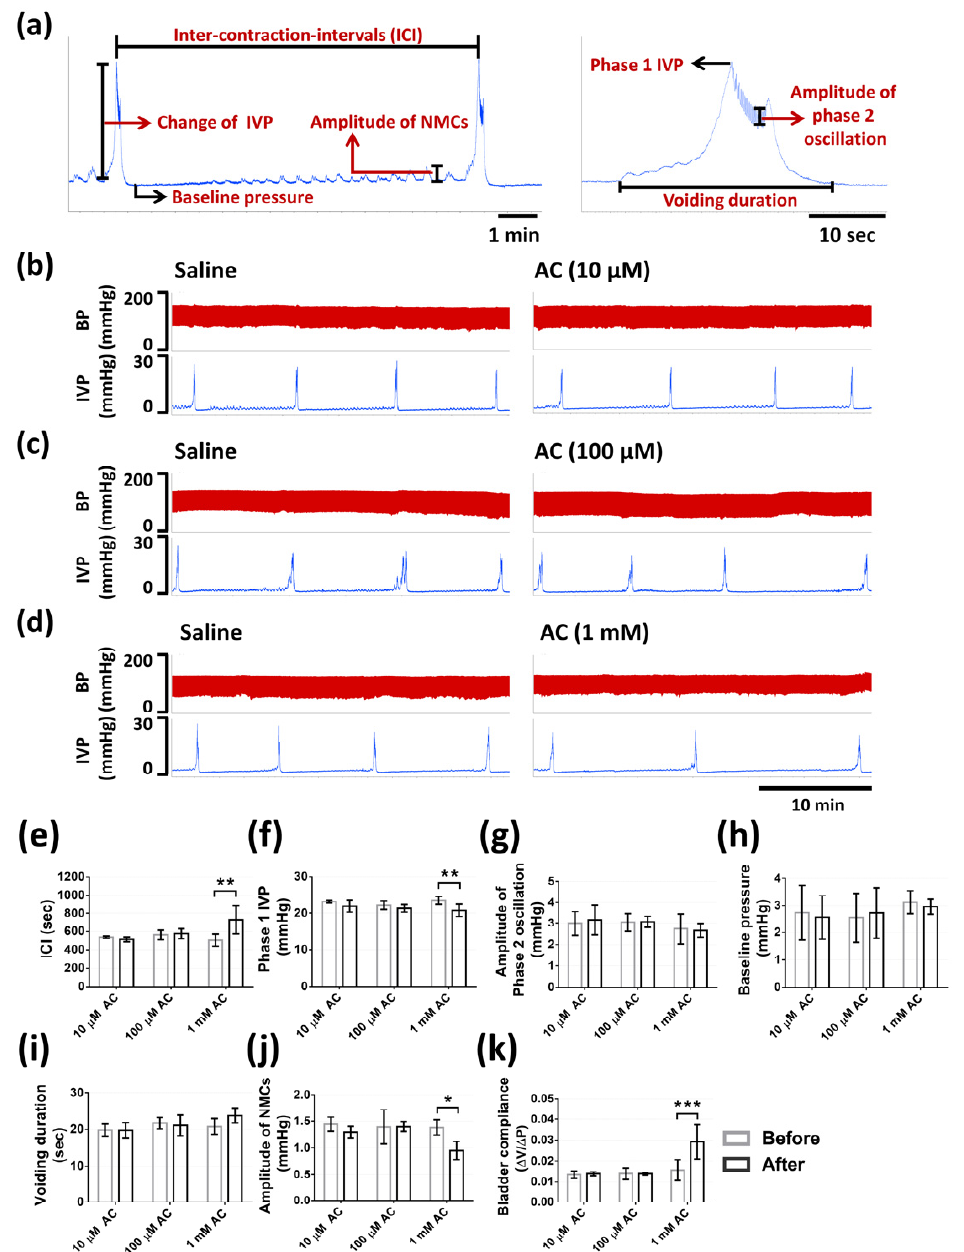
Figure 4. The effects of different dosages of CaSR agonist (AC) on micturition. ( a ) Illustration of micturition function parameters that were measured in this study. Effects of intravesical adminis- trations of 10 µ M AC ( b ) ( n = 3), 100 µ M AC ( c ) ( n = 3), and 1 mM AC ( d ) ( n = 6) on micturition with the recording of intravesical pressure (IVP) and blood pressure (BP). The statistical analysis of micturition function parameters before (saline) and after different treatments, including inter- contraction-intervals (ICI) ( e ), phase 1 IVP ( f ), amplitude of phase 2 oscillation ( g ), baseline pressure ( h ), voiding duration ( i ), amplitude of non-micturition contractions (NMCs) ( j ), and bladder com- pliance ( k ) (Two-way ANOVA with Sidak’s post hoc tests; * p < 0.05, ** p < 0.01, *** p < 0.001, as compared with saline treatment in each